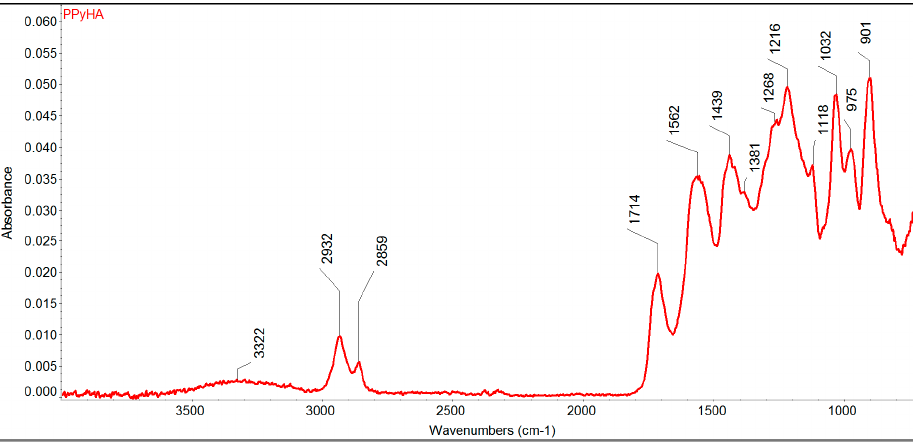
Figure 4. Infrared (IR) spectrum of the resulting PPyHA powder after washing off the PCL.